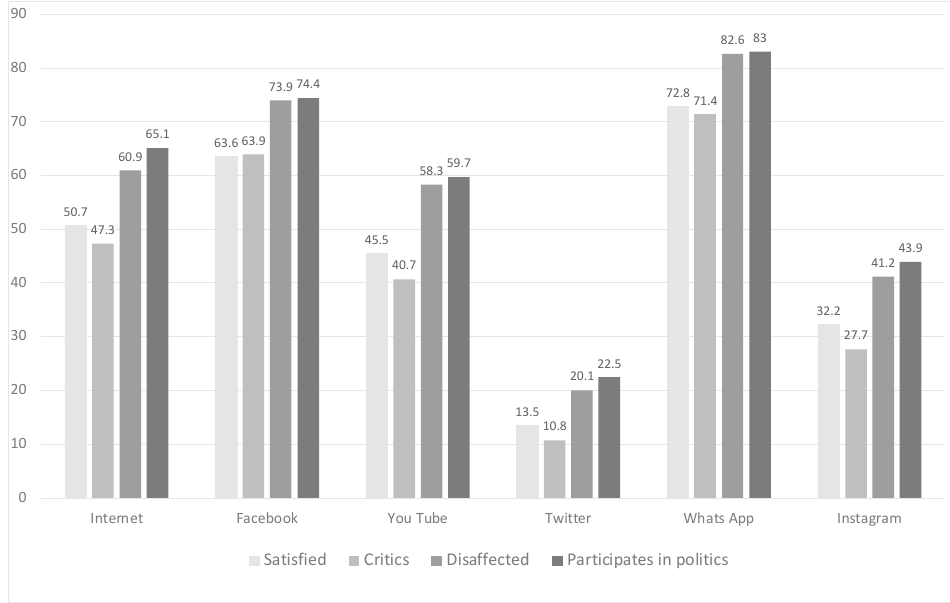
Figure 9. Following of social networks and citizen type. Source: Latinobarometer 2020. Figure 8. Following of social networks and citizen type. Source: Latinobarometer